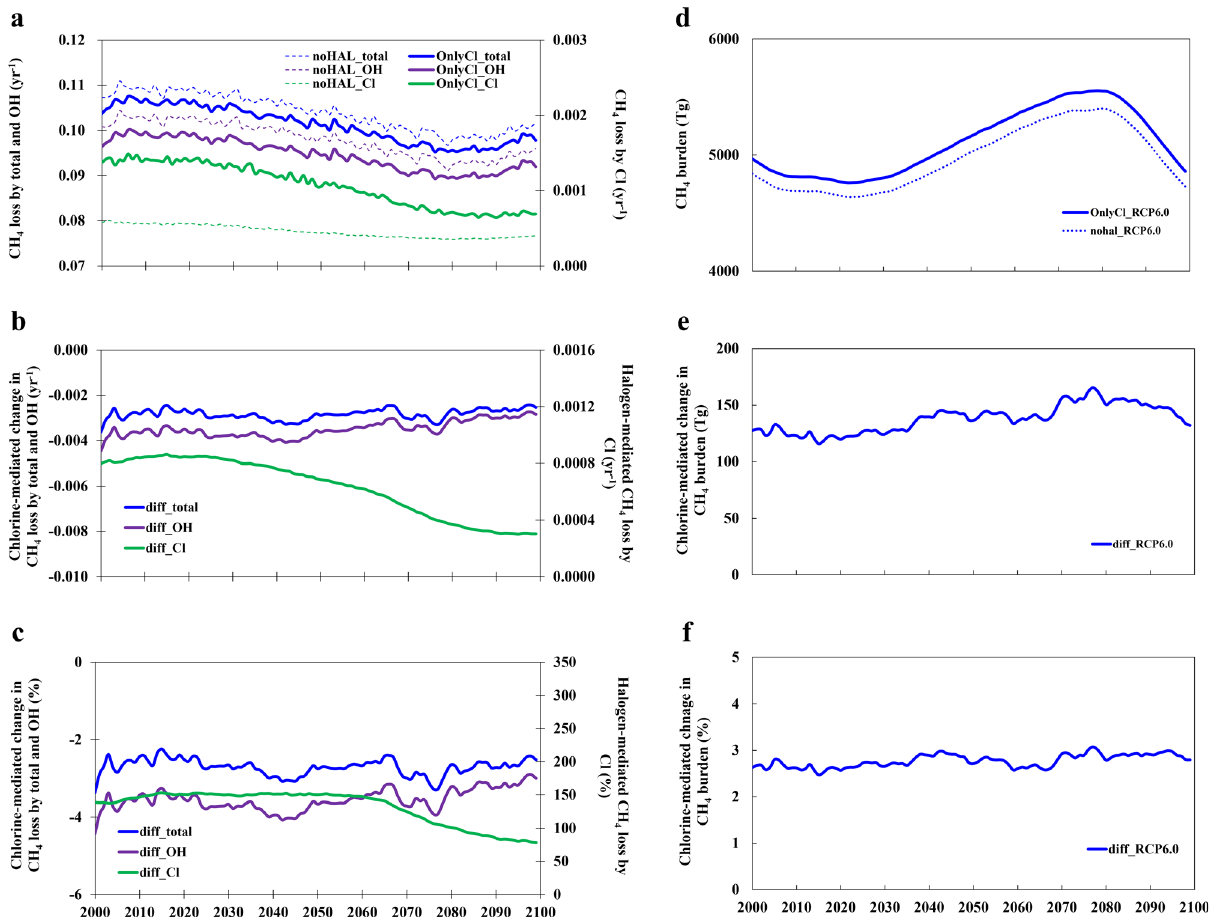
Fig. 6 Evolution of the chlorine-mediated change in CH 4 loss rate and burden in the 21st century in the OnlyCl case. a The total CH 4 loss (yr − 1 ; blue line) and the CH 4 loss (yr − 1 ) by OH (purple line) and Cl (green line) radicals in both noHAL and OnlyCl cases. b Chlorine-mediated change in CH 4 loss in yr − 1 for the total (blue), OH (purple line), and Cl (green line) channels. c The same as ( b ) but in percentage. Note that the chlorine-mediated changes are calculated with a moving average of 10 years (approximately the lifetime of CH 4 in the atmosphere). d CH 4 burden (Tg) in OnlyCl (solid line) and noHAL (dashed line) cases; e Chlorine-mediated change in CH 4 burden in units of Tg; f The same as ( e ) but in